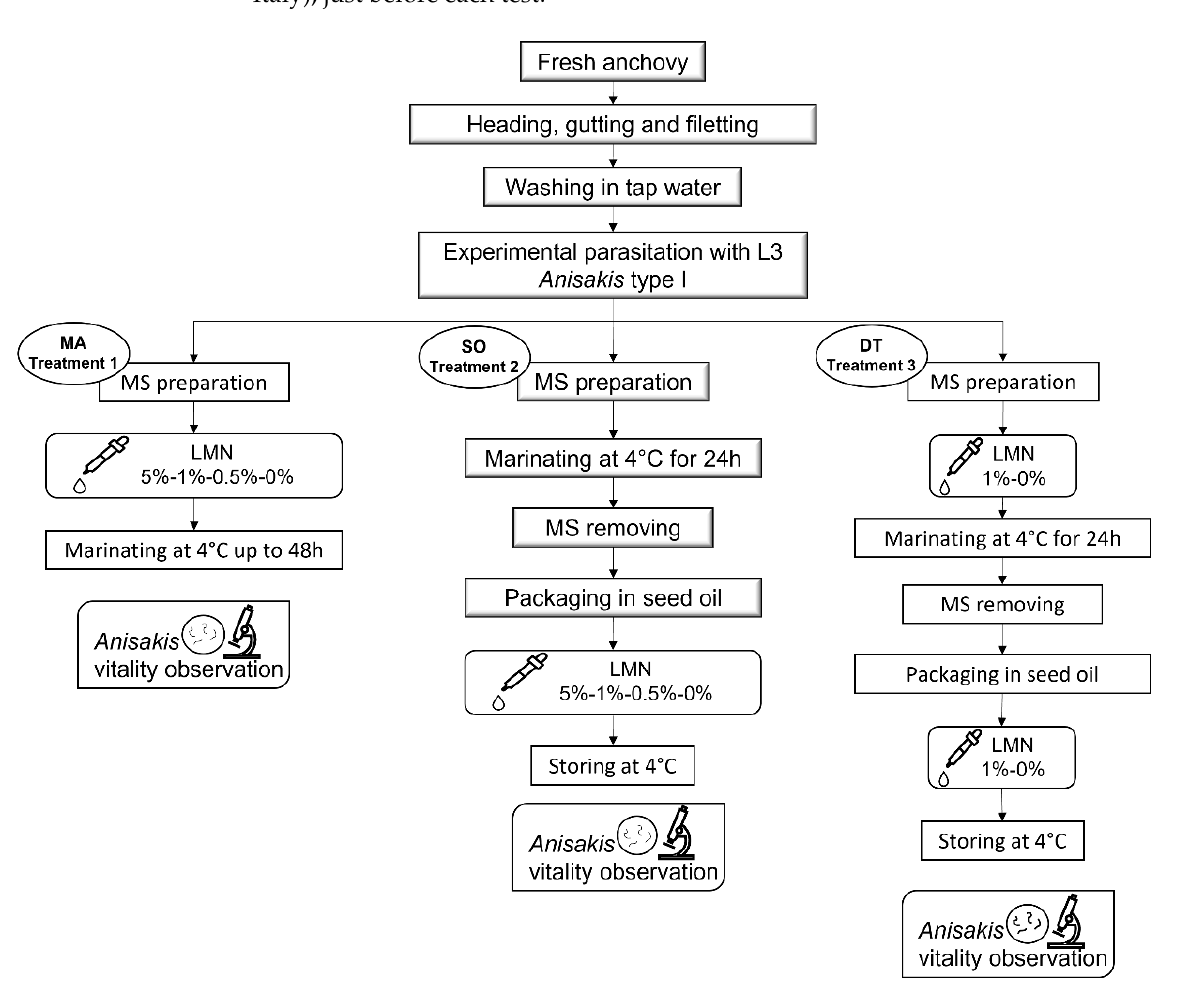
Figure 1. Flow chart of the different treatments with R (+) limonene (LMN) in the traditional industrial marinating process of anchovy fillets. MA: marinating; MS: marinating solution; SO: sunflower seed oil; DT: double treatment.